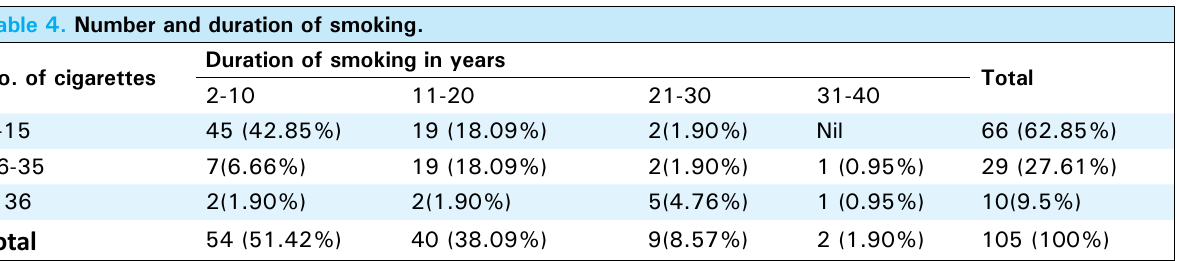
table 4. Number and duration of smoking.